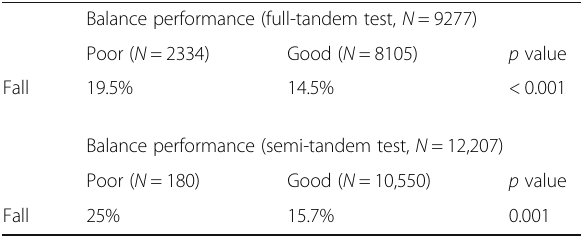
Table 1 Validity of self-reported fall among mid-aged